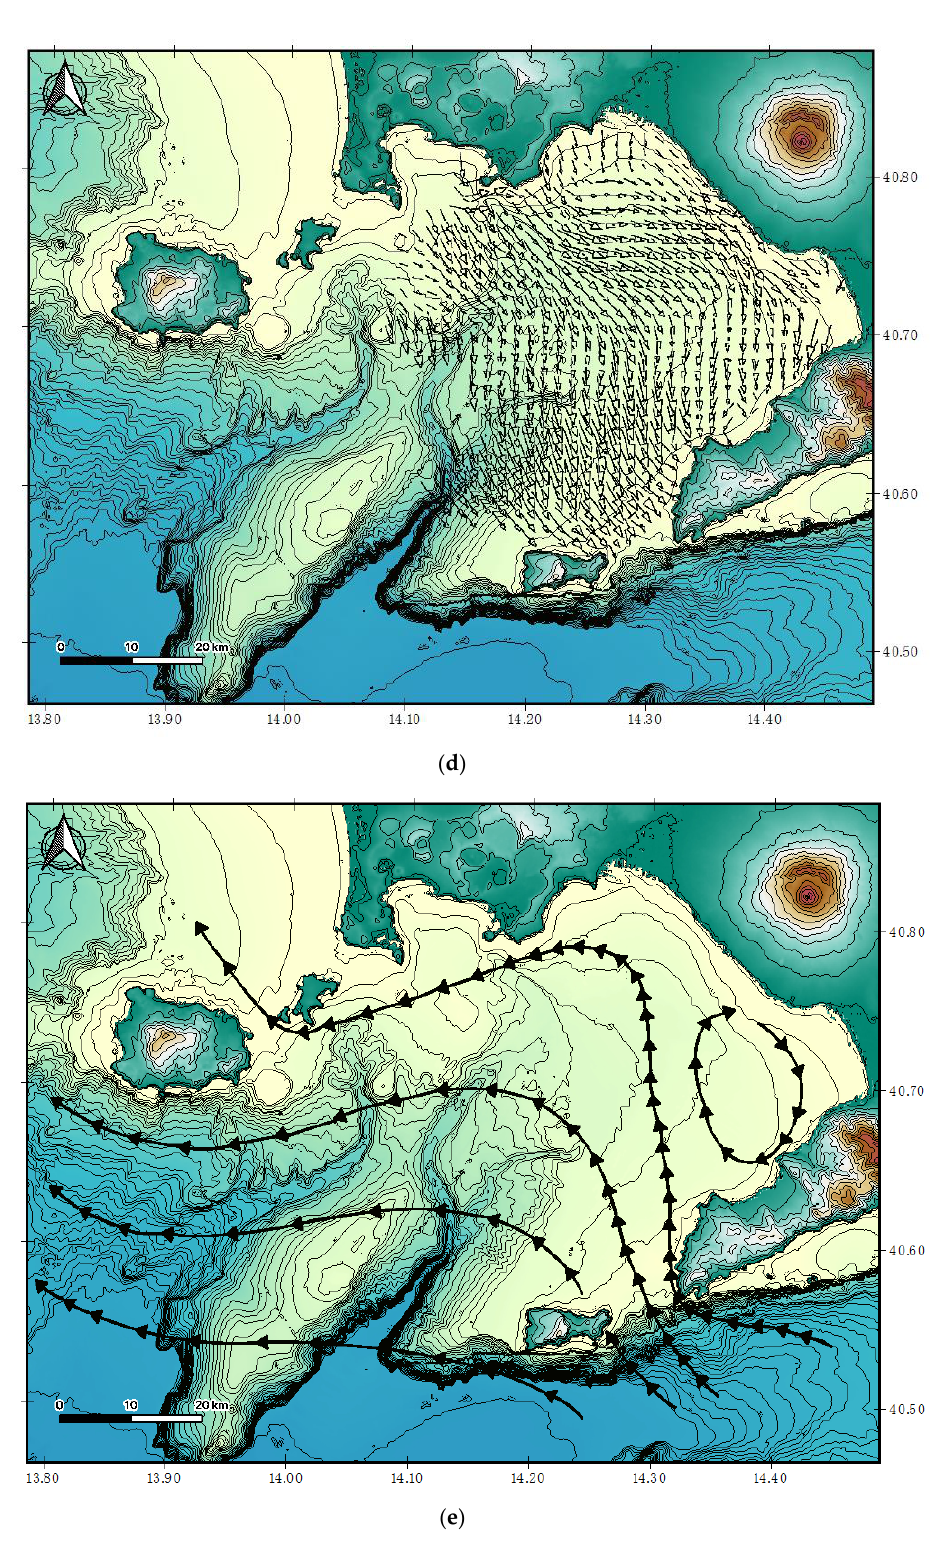
Figure 3. ( a ) Superficial circulation as controlled by a NE wind (modified after Cianelli et al., 2011) [79]; ( b ) superficial circulation as controlled by a SW wind (modified after Cianelli et al., 2011) [79]; ( c , d ) superficial circulation as controlled by the daily alternation of breeze winds; ( e ) oceanographic circulation as controlled by a NW Tyrrhenian